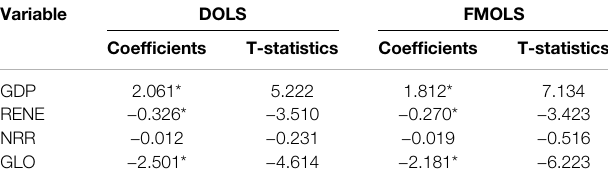
TABLE 6 | Robustness estimator outcome.